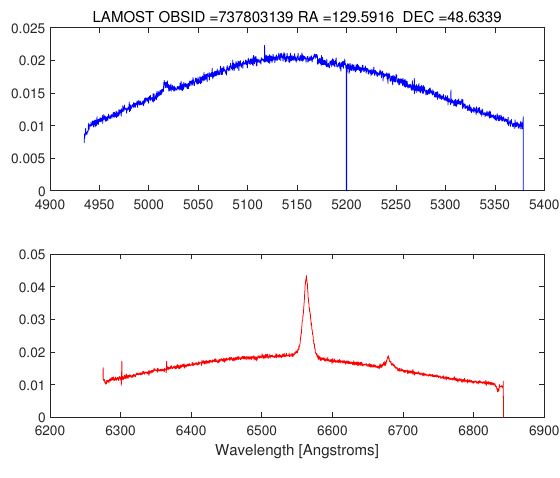
Figure 15. Dwarf Nova.